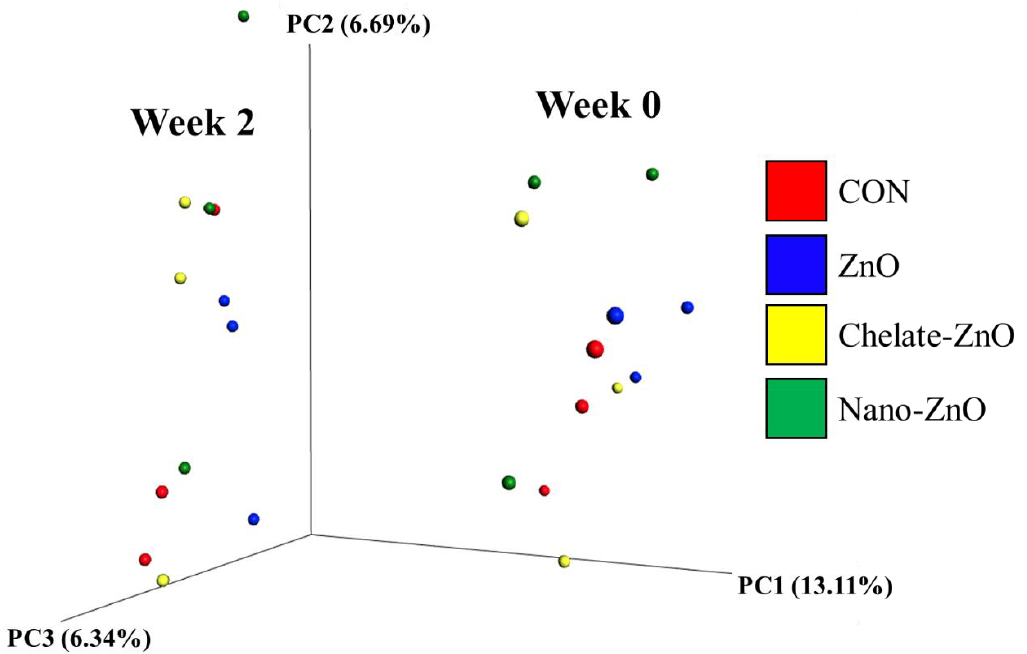
Figure 9. Principal coordinates analysis (PCoA) plots of ZnO treatment (CON; red. ZnO; blue, chelate-ZnO; yellow, nano-ZnO; green) in weeks. Week 0 ( right ) and week 2 ( left ) group clustered significantly based on unweighted UniFrac distance metrics ( p < 0.05, R: 0.498346).